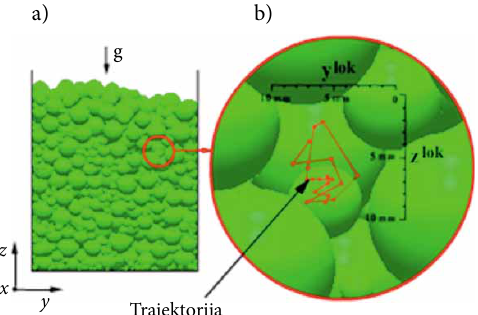
Fig. 12. Changes in the vector z component of the position of the i th particle considering time